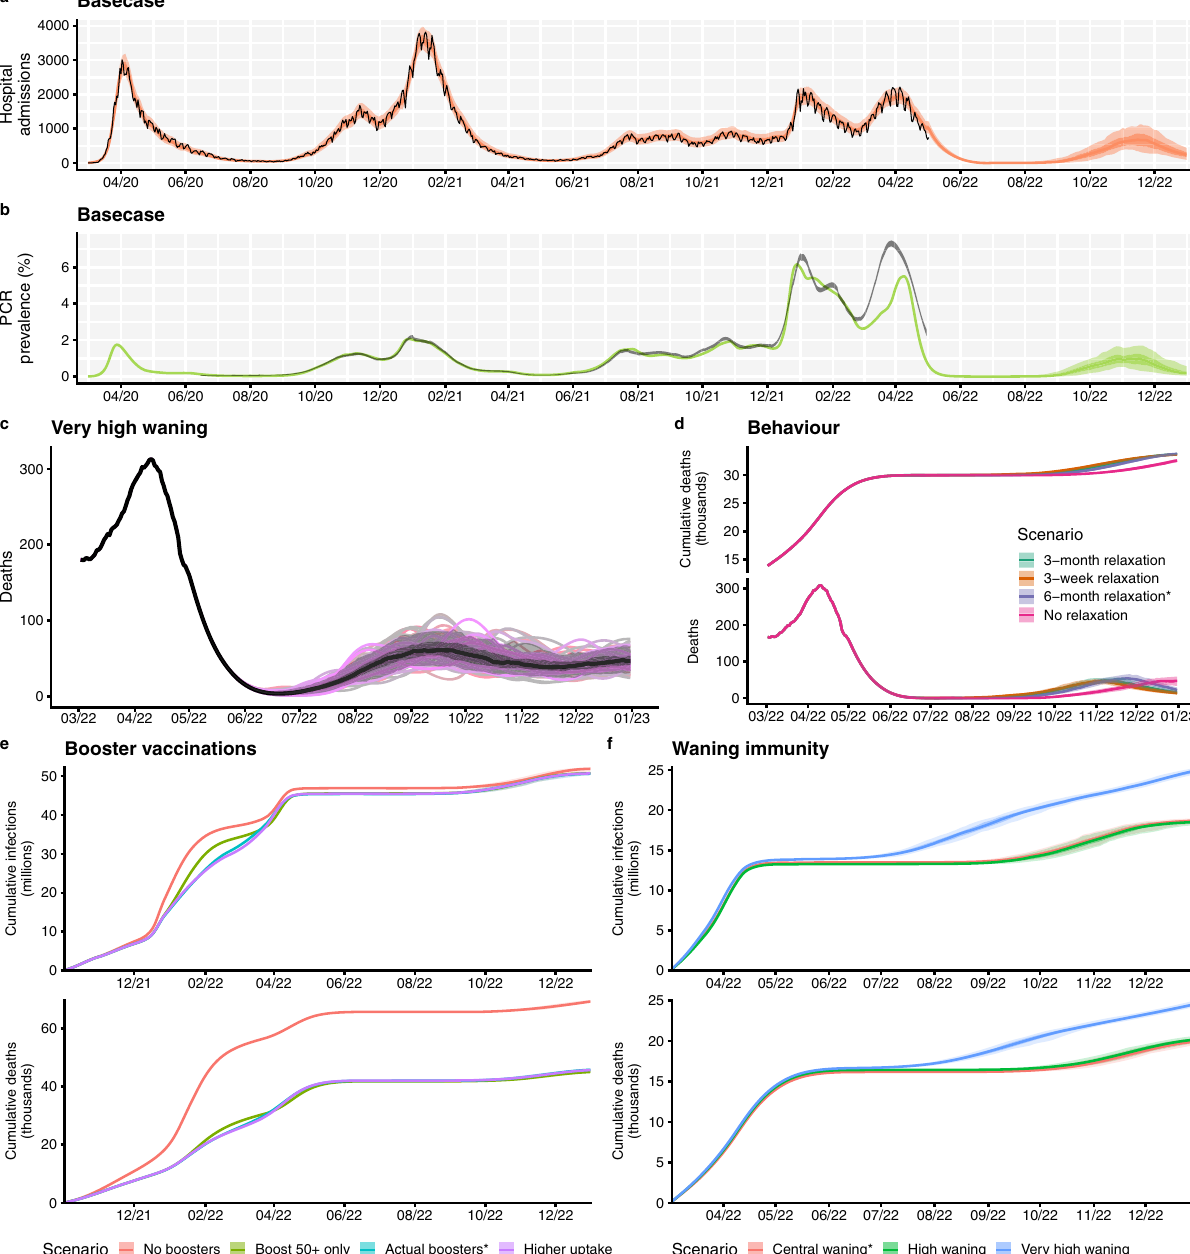
trajectories are plotted in coloured lines. d The effect of future behaviour on COVID-19 deaths and cumulative deaths (thousands) over time is shown with four scenariosforfuturemobility:a3-week,a3-monthanda6-monthreturntobaseline levels, and a no change scenario (see Table 1). Coloured lines and shaded areas show medians, 50% and 90% interquantile ranges from the fi tted model and from the model projection. e The effect of booster vaccination policy on cumulative infections and deaths since October 2021 is shown with four scenarios for booster policies (Table 1). Coloured lines and shaded areas show medians, 50% and 90% interquantile ranges from the fi tted model and from the model projection. f The effectofwaningimmunityoncumulativeinfectionsanddeathsbetweenMarchand December 2022 is shown with three scenarios for waning (Tables 1, S4). Coloured lines and shaded areas show medians, 50% and 90% interquantile ranges from the fi ttedmodelandfromthemodelprojection.Thebasecasescenarios(shownin a , b ) and scenarios marked with an asterisk (*) are